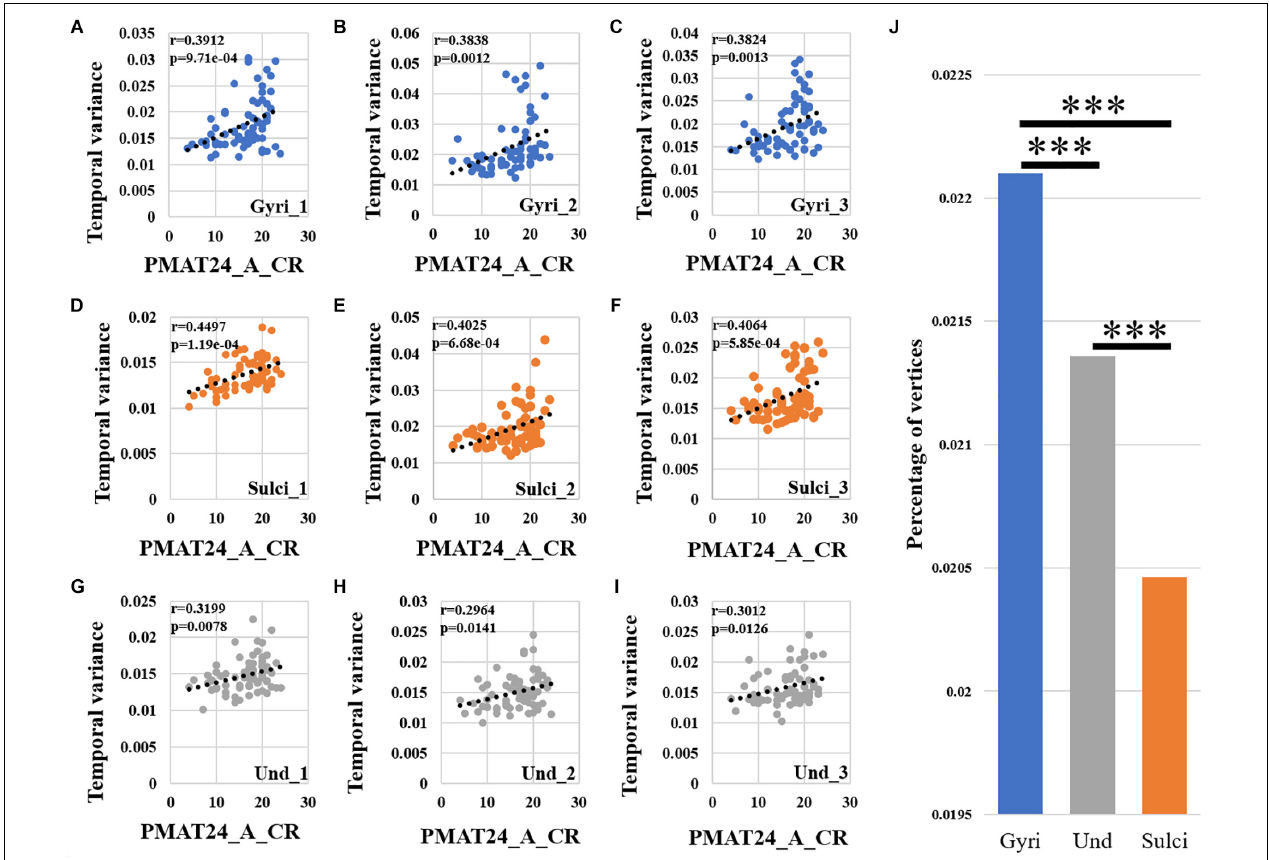
FIGURE 5 | Correlation between temporal variability of functional activity and fluid intelligence measure “number of correct responses” (PMAT24_A_CR) across all brain regions. (A–C) The correlations between temporal variance and “number of correct responses” measure across all 68 subjects of three example gyral vertices, respectively. (D–F) The correlations between temporal variance and “number of correct responses” measure across all 68 subjects of three example sulcal vertices, respectively. (G–I) The correlations between temporal variance and “number of correct responses” measure across all 68 subjects of three example undefined vertices, respectively. (J) The mean percentage of gyral/sulcal/undefined vertices with significant positive correlations with the “number of correct responses” measure across all 68 subjects. ∗∗∗ Indicates p <